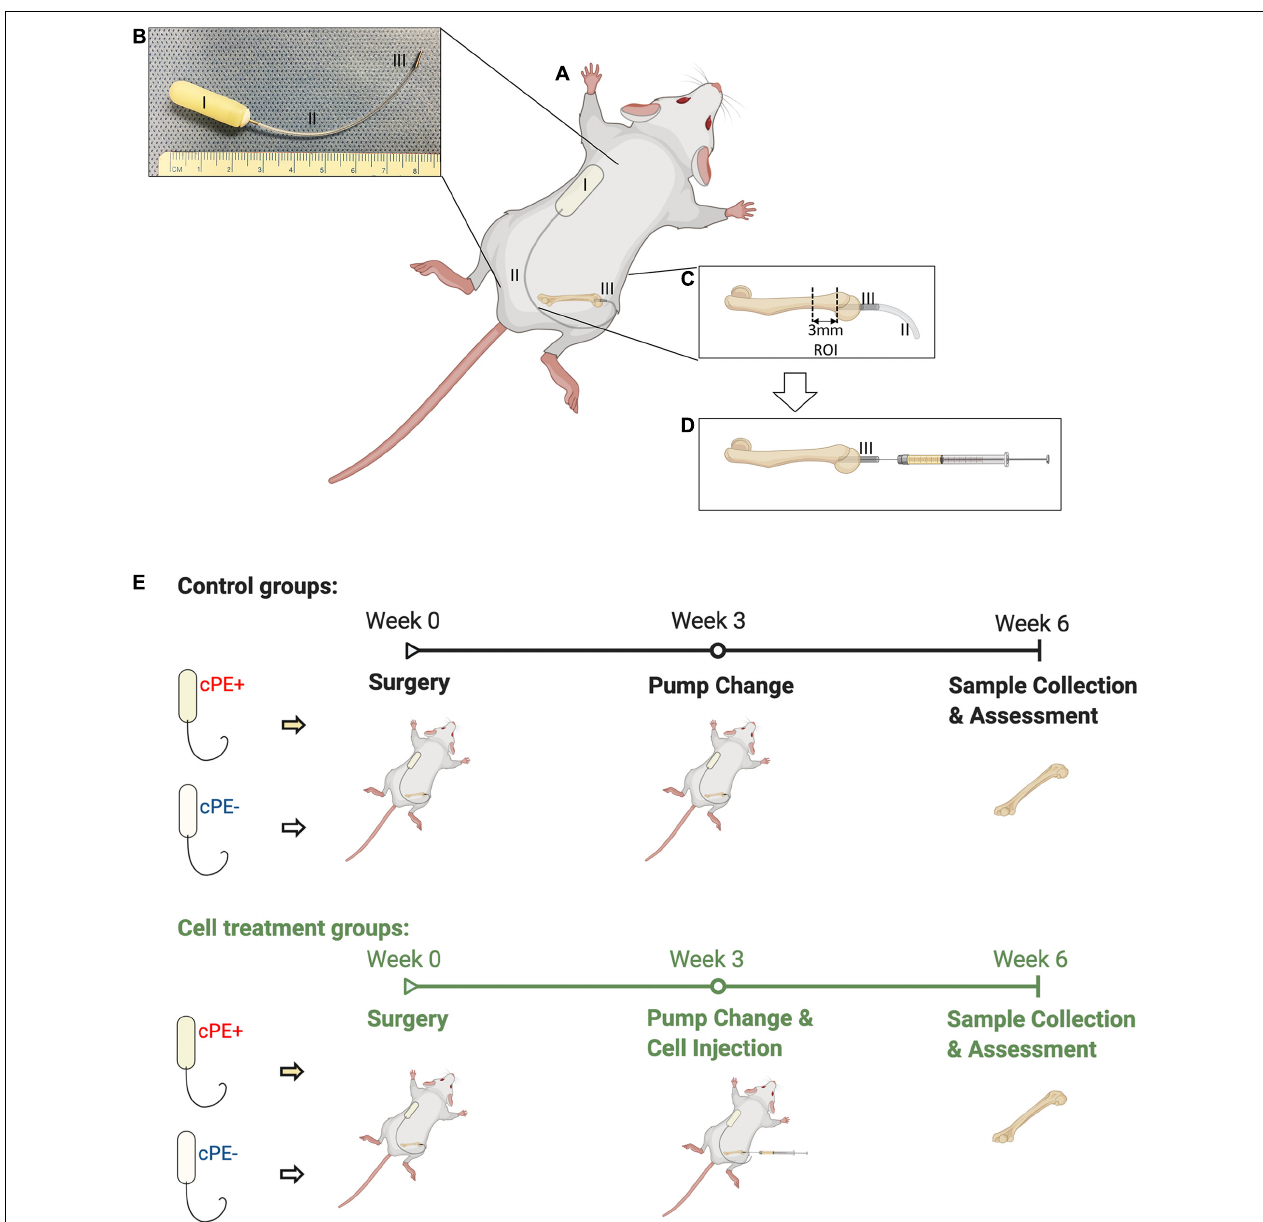
FIGURE 1 | Continuous femoral infusion murine model generation and experimental design based on the treatments. (A) The murine continuous femoral infusion model. (B) Infusion system. I: osmotic pump; II: connected tube; III: hollow titanium rod. (C) Rod press-fit into the distal femoral canal and the selected ROI for assessments. (D) Cell injection at 2nd surgery. (E) Summary of the treatments and experimental